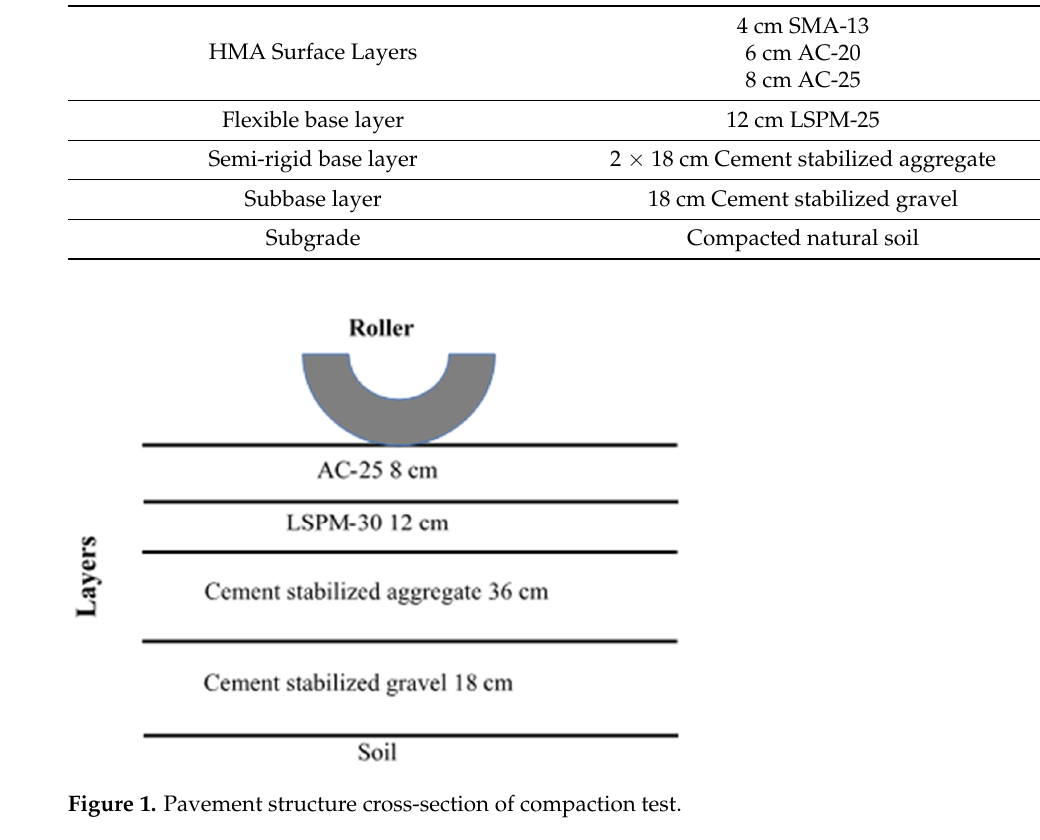
Figure 3. Test lanes. Figure 4. PQI380 used in in-situ test.